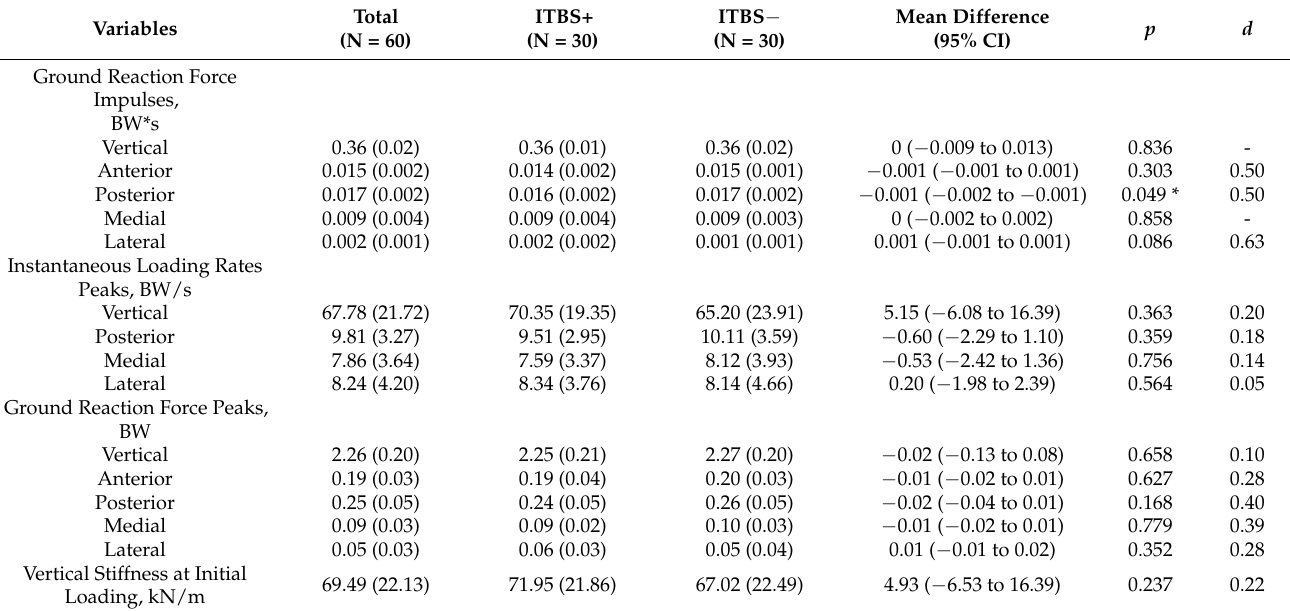
Table 2. Average ground reaction force data in running cohort with and without ITBS (n =